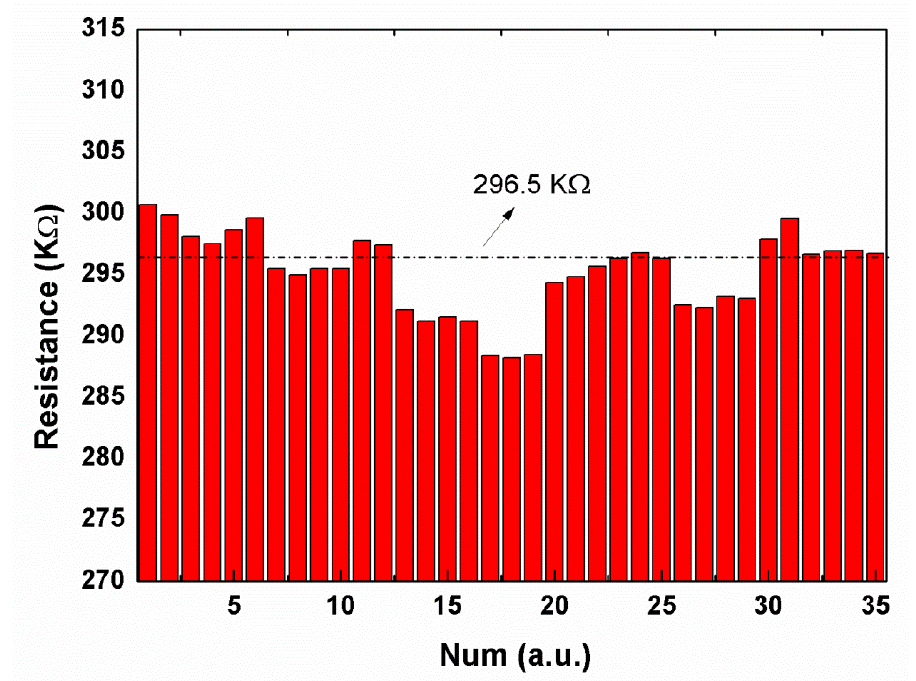
Figure 10. The resistance of thermopile devices tested by 1 V voltage.